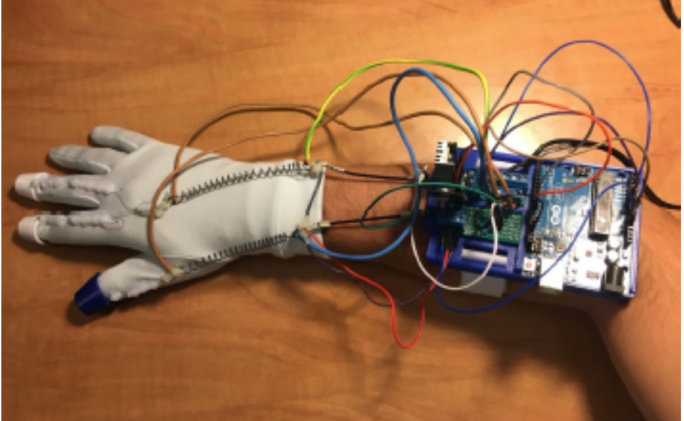
Figure 4. Final Haptic